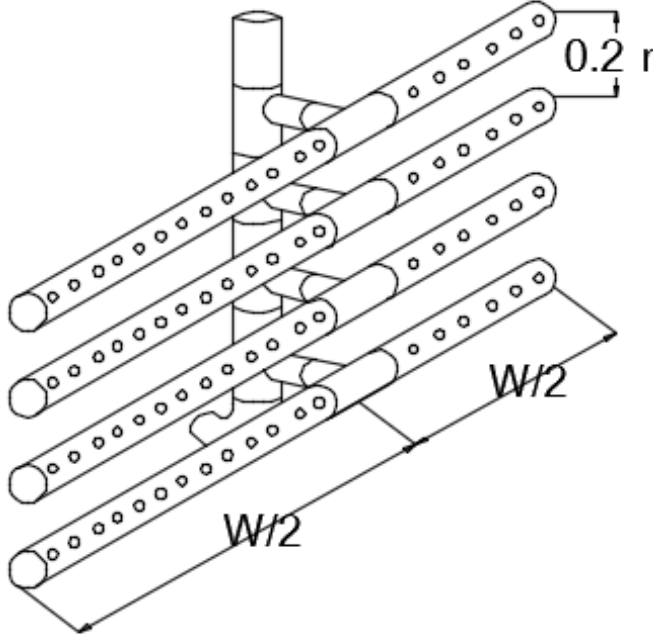
Figure 5. Innovative device for the effluent of the subsurface flow wetland, Patent Registration [27].